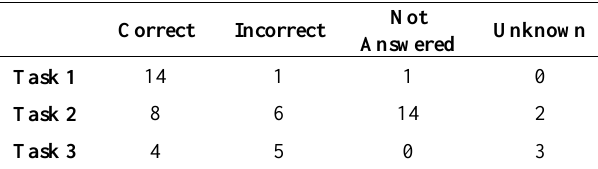
Table 6. Comparison analysis between reference and collected data of tree names